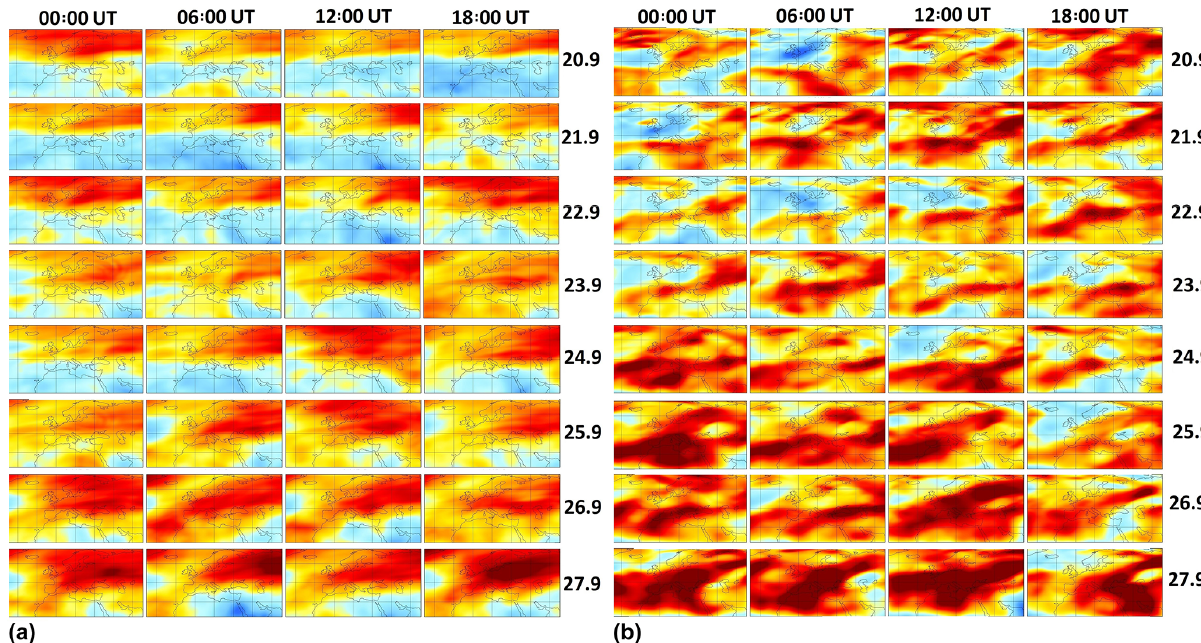
Figure 6. Stratospheric wind above Europe at 1hPa (a) and at 0.1hPa (b) . Red color represents eastward wind, and blue represents westward wind.